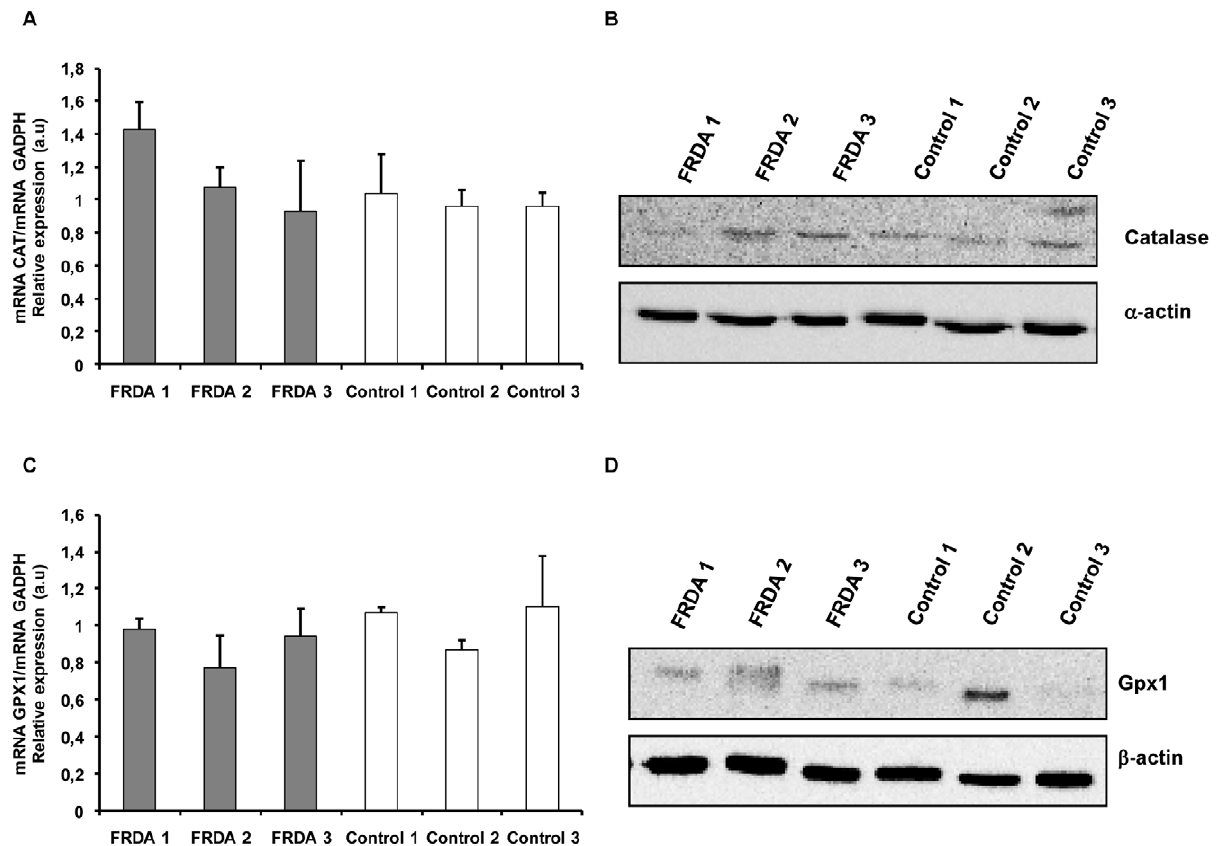
Figure 2. Analysis of hydrogen peroxide detoxifying enzymes in FRDA and control cells. A. Mean ( 6 SD) mRNA levels for CAT gene analyzed by triplicate. B. Catalase protein levels measured by Western blot. C. Mean ( 6 SD) mRNA levels of Gpx1 analyzed by triplicate. D. Determination of Gpx1 protein levels by Western Blot.